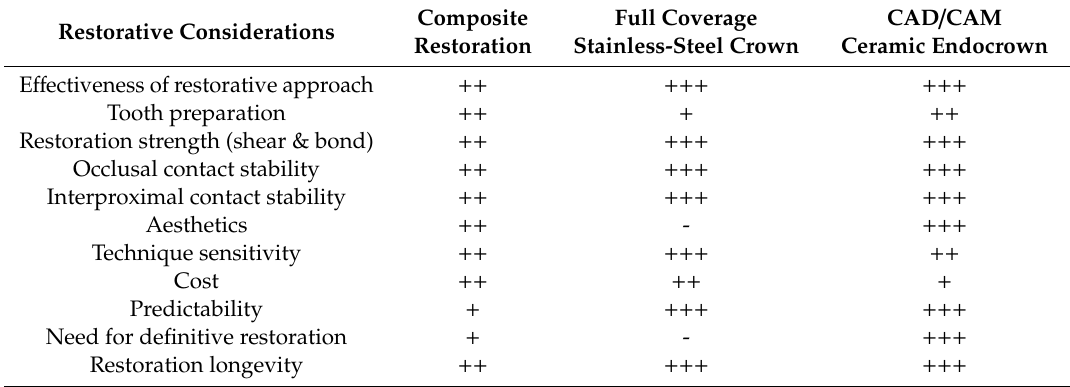
Table 1. Decision-making considerations regarding the restoration restorative options for endodontically- treated teeth in